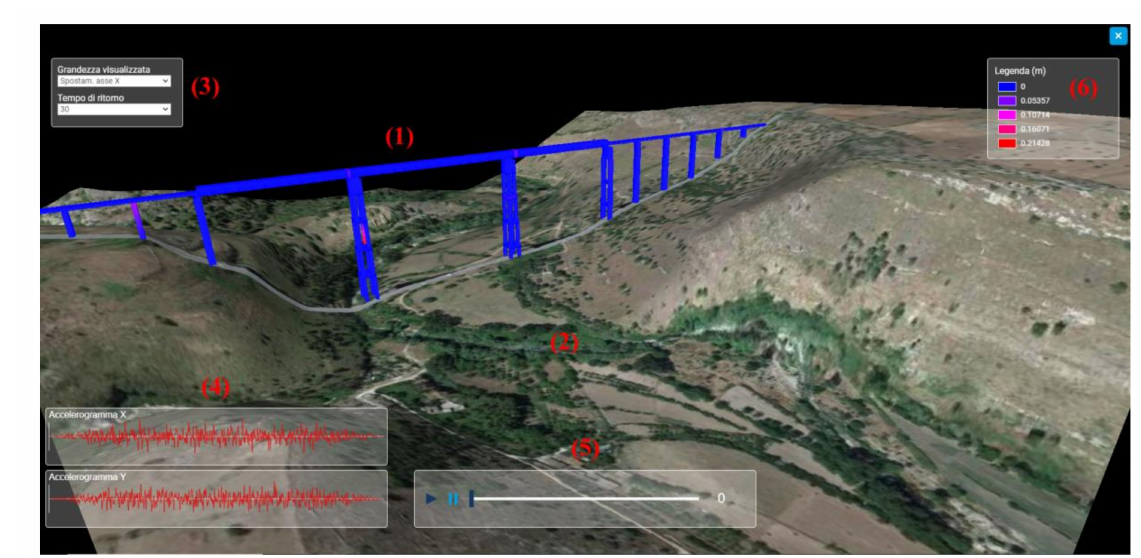
Figure 28. Three-dimensional display